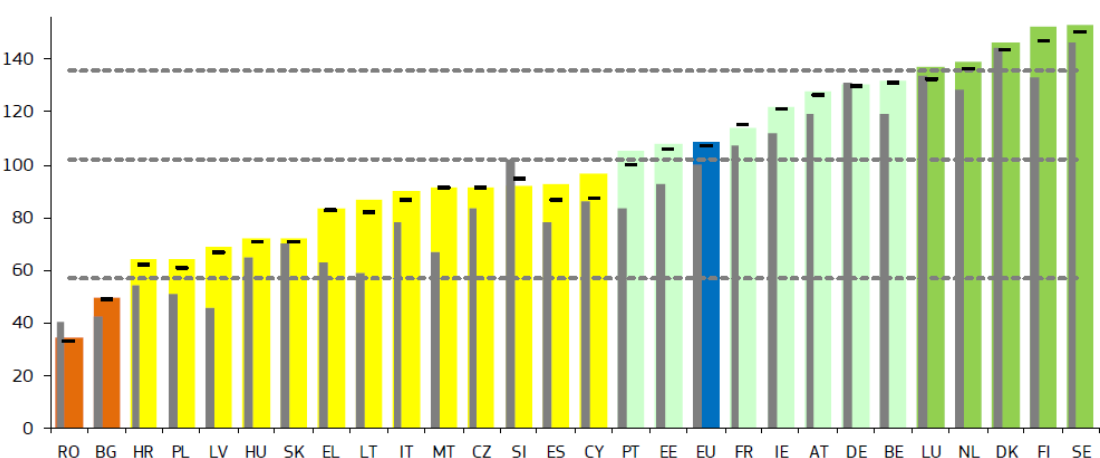
Fig. 1. European Innovation Scoreboard 2020